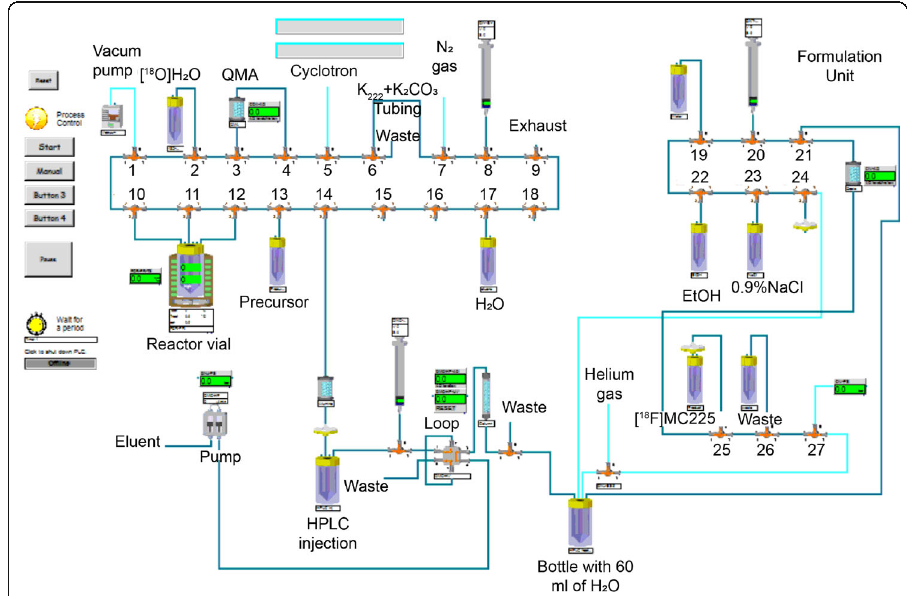
Fig. 6 Scheme of Eckert & Ziegler module for the synthesis of [ 18 F]MC225 using a 1-step